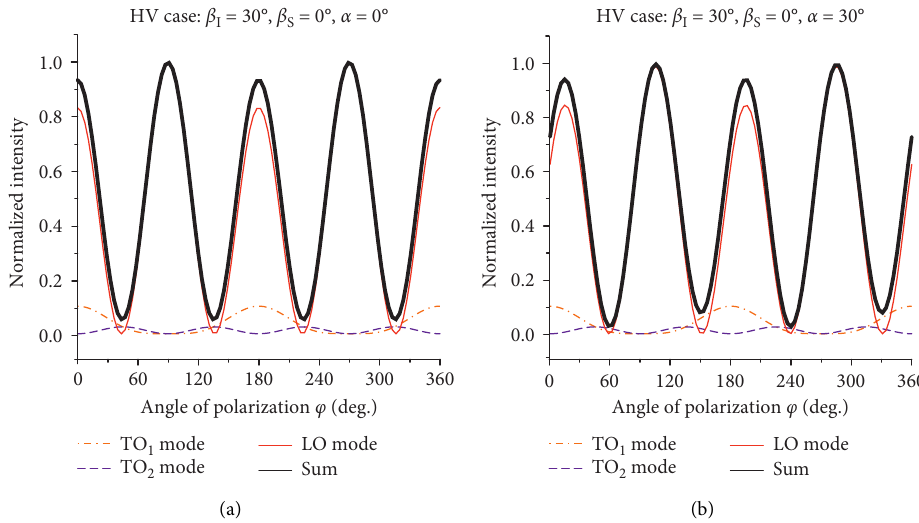
Figure 13: Intensity distributions of Raman modes in the HH case under off-axis scattering ( β directions φ and sample rotation angles: (a) α � 0 ° and (b) α � 30 ° .